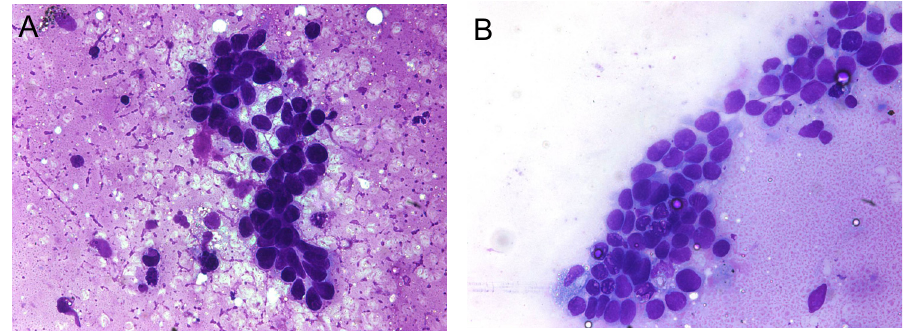
Figure 2. Fine needle aspiration (Diff-Quick preparation, original magnification ×400) from a lung nodule demonstrates a ) Cells with a high nuclear to cytoplasmic ratio and mildly enlarged nuclei compared to surrounding inflammatory cells in the background, b ) Enlarged, fairly uniform cells forming